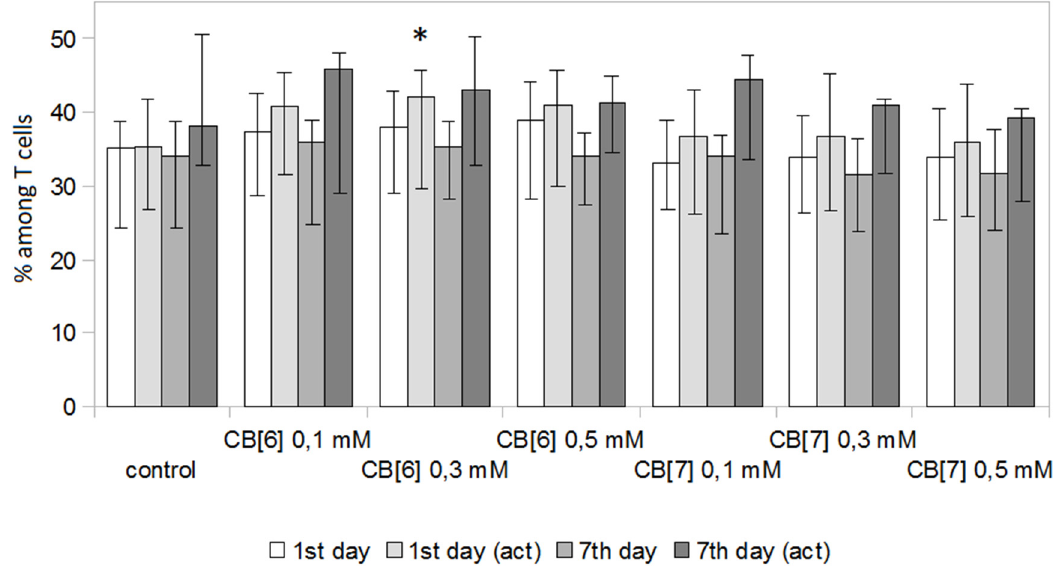
Figure 4. Percentage of CD3 + CD4 ‐ cytotoxic T cells in PBMCs cultivated in the presence of various concentrations of CB[n]. Data are presented as the median with interquartile range. (* Indicates a significant difference ( p < 0.05) vs. the control. (act)—Culture of PBMCs activated with anti ‐ CD3 antibodies.